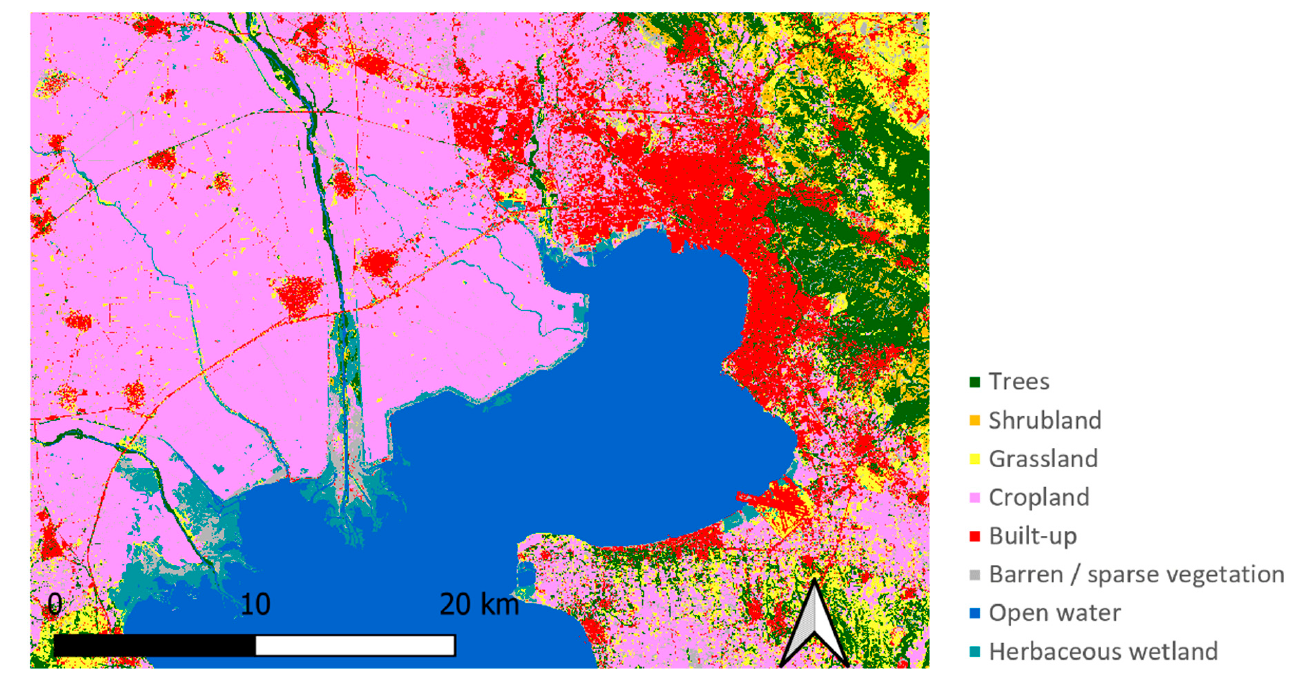
Figure 7. The ground truth segmentation map of the testing set (Thessaloniki).